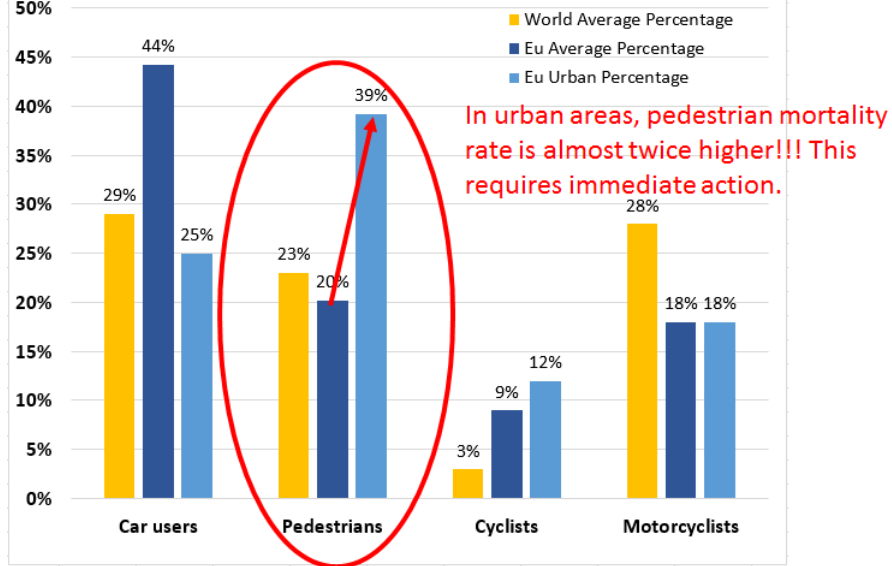
Figure 1. Percentage distribution of the mortality among the main road user categories, suggesting the high vulnerability rate among pedestrians, especially in urban areas.